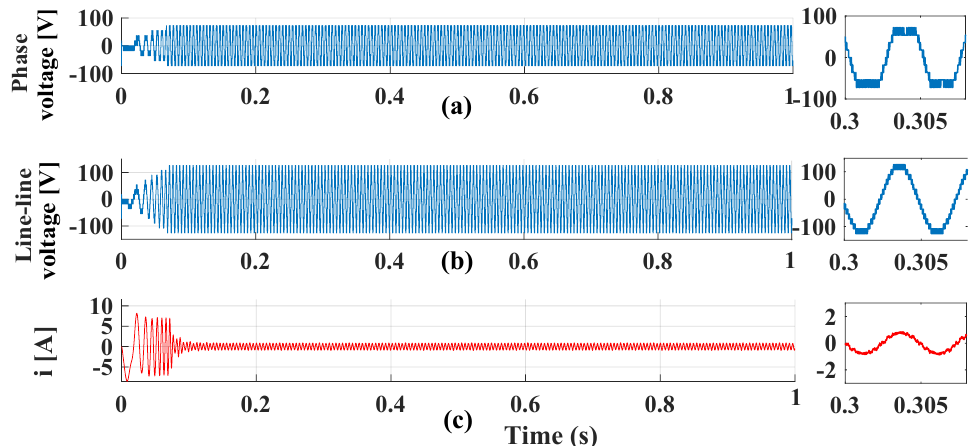
Figure 11. Simulation result of the 9-level inverter: ( a ) Phase voltage. ( b ) Line-line voltage. ( c ) Phase current.